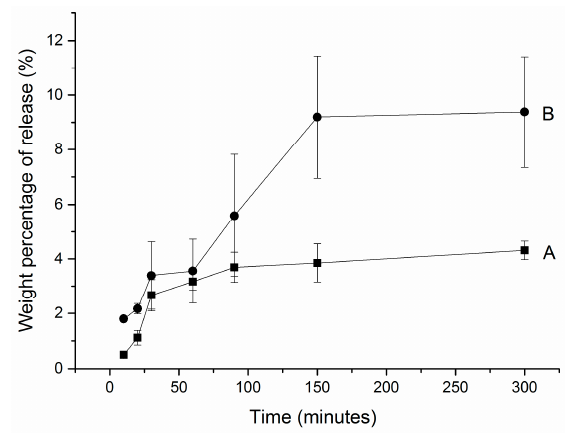
Figure 2. Hydrogen peroxide release profiles from ( A ) CP ‐ loaded HCPS and ( B ) modified CP ‐ loaded HCPS. ( A ) 0.5 g spheres, 2.475 g CP, and 9.5 mL water were mixed with stirring for 2 h at room temperature; ( B ) 0.5 g spheres, 2.475 g CP, 0.5 g 35% HP (total mole ratio of HP: urea = 1.2:1), and 9.5 mL water mixed with stirring for 2 h at 9 °C.